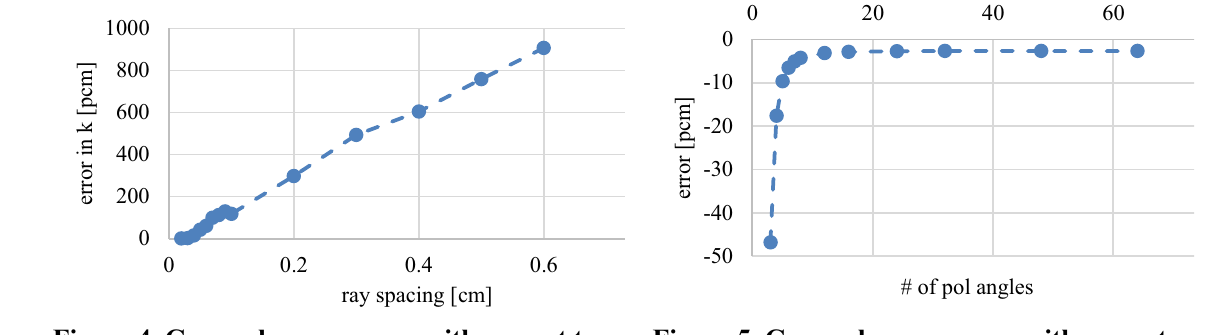
Figure 5. Ganapol convergence with respect to the number of polar